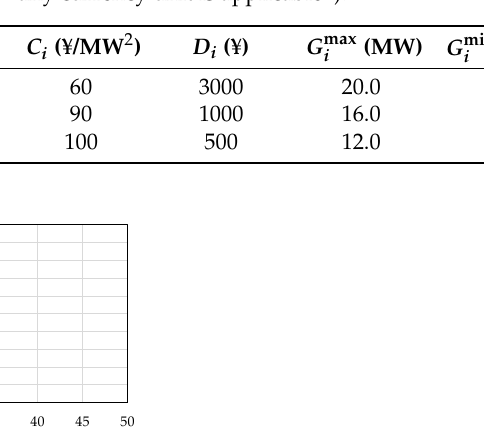
Table 2. Calculated coefficients in Figure 3 (“¥” means “any currency unit is applicable”).